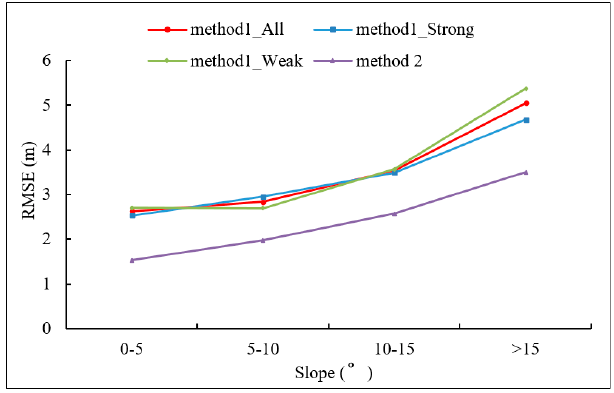
Figure 8. The relationship between the RMSE of slope errors and surface topography.